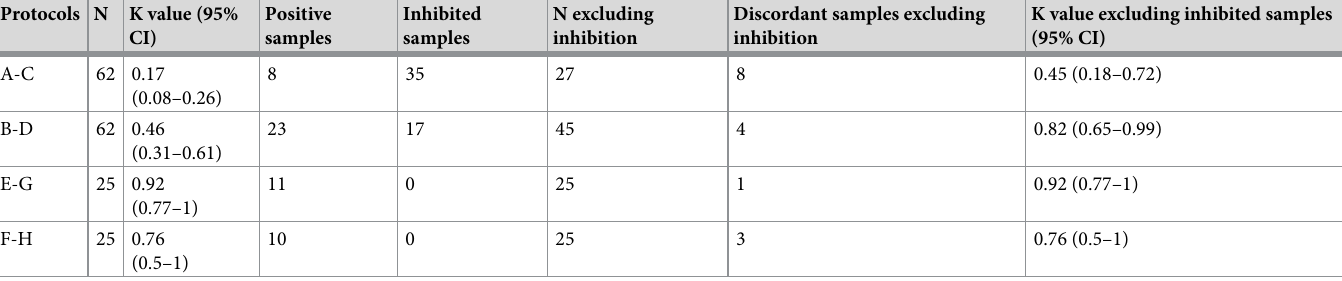
Table 6. Cohen’s kappa coefficient (K) results for the comparison between protocols with the DNA extraction system as the only variable. K values are shown including and excluding inhibited samples. Protocols N K value (95%